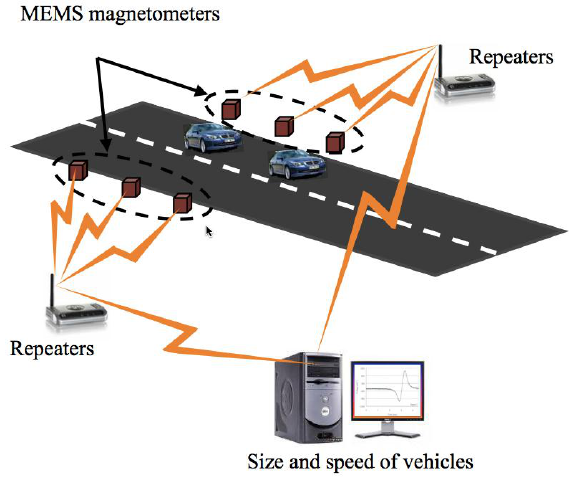
Figure 27. Schematic view of traffic detection system formed by MEMS devices and signal processing [36]. Reprinted with permission from [36]. Copyright@2011, Intech.